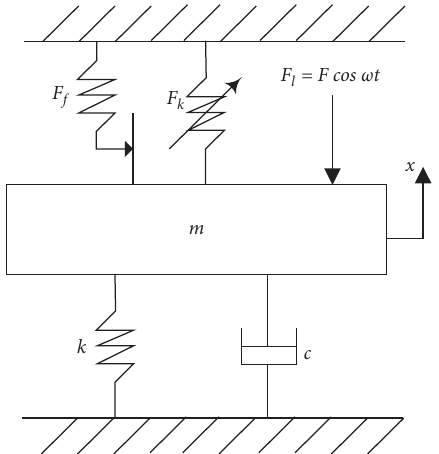
Figure 2: The vibration model of the rolling mill